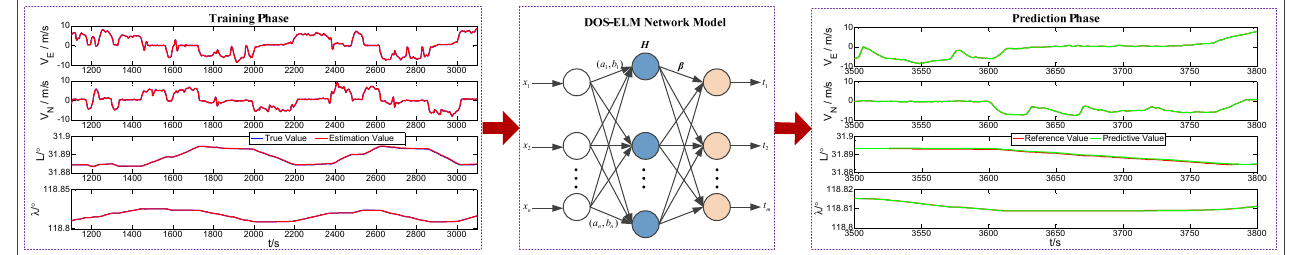
Figure 6. The vehicle’s dynamic characteristics during the experiment. Figure 7. Intelligent estimation process of pseudo GPS speed/position. Figure 7. Intelligent estimation process of pseudo GPS speed/position.